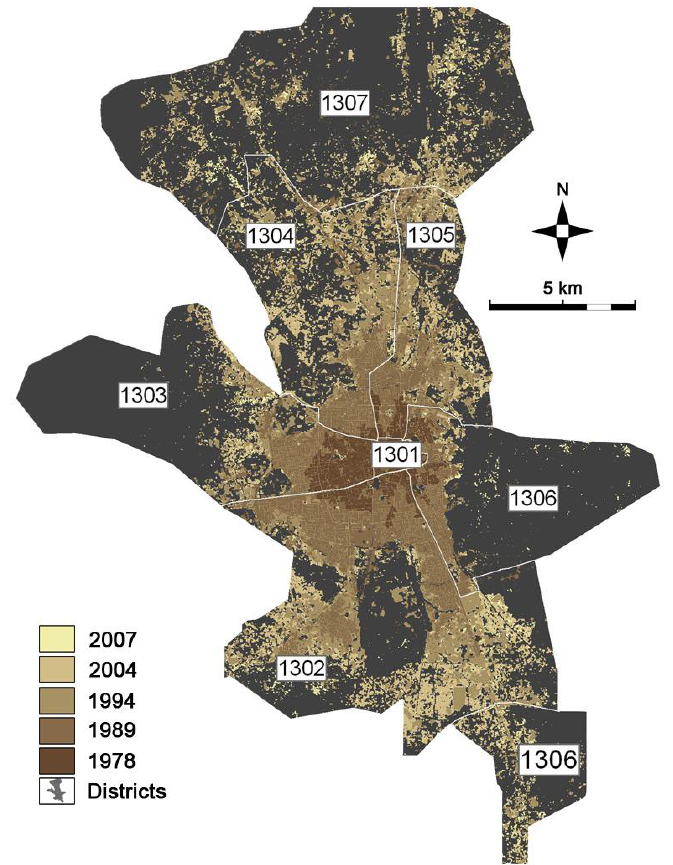
Figure 6. Urban expansion (1978–2007) and district map. Note that district 1306 consists of two